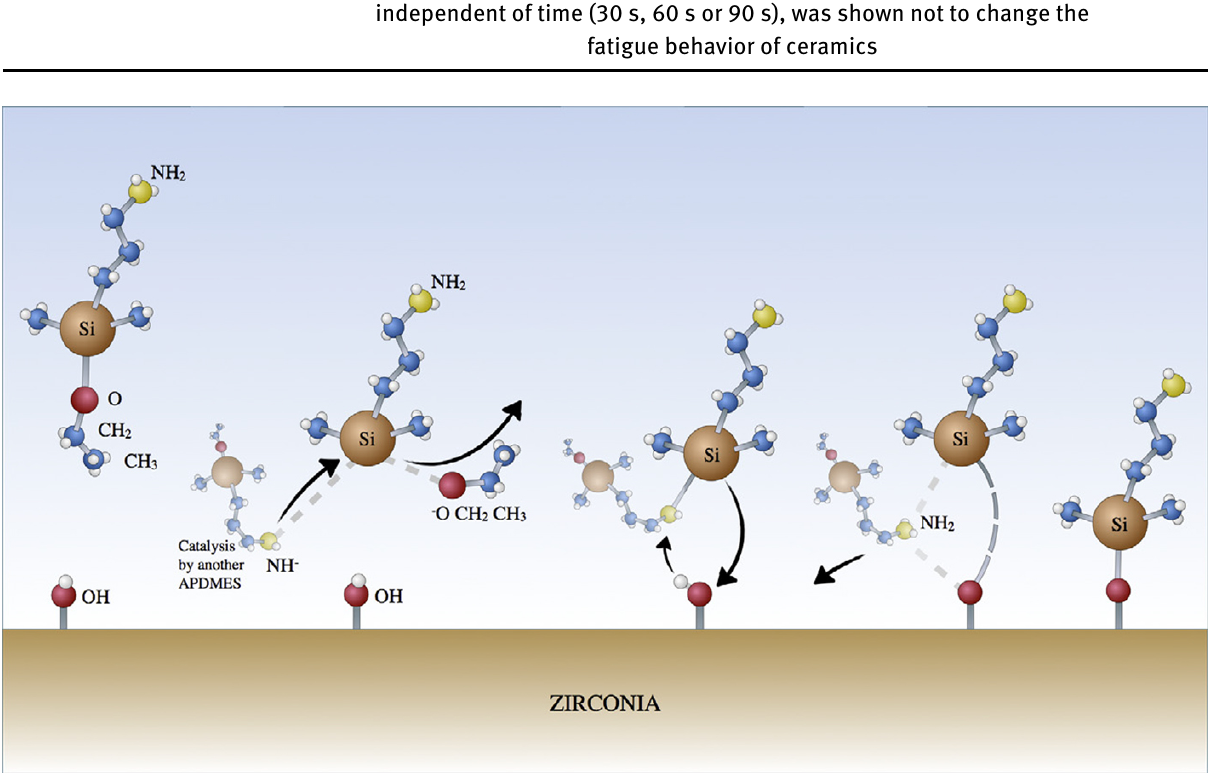
Figure 4: Schematic representation of silanization [74]